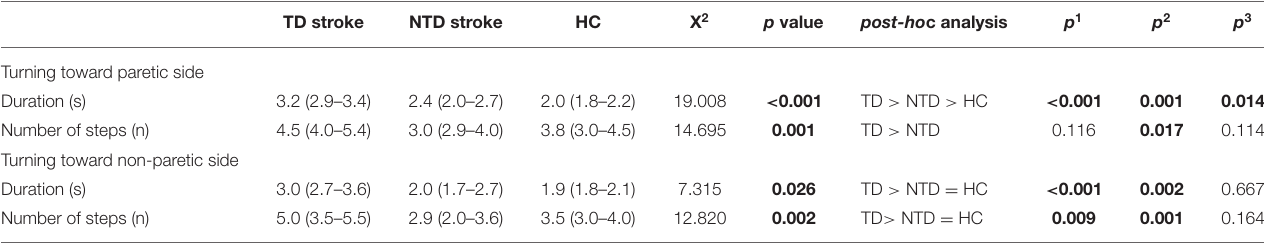
TABLE 2 | Duration (s) and number of steps (n) for stroke participants with and without turning difficulty and healthy controls during 90 ◦ standing